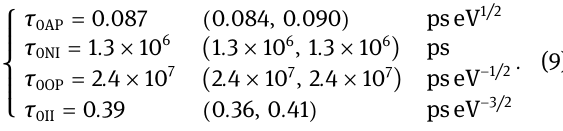
Figure 3a. The acoustic phonon scattering and ionized im- signi fi cant mechanisms because of their short scattering